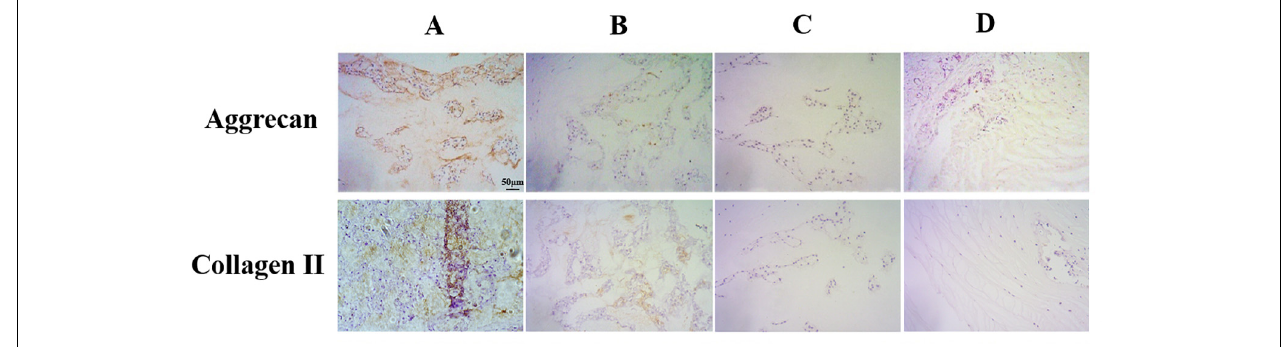
FIGURE 7 | Immunohistochemical staining of aggrecan and collagen II expression in the nucleus pulposus samples (original magnification, × 200; scale bar, 50 µ m). The expression of aggrecan and collagen II significantly decreased in group B and group C and group